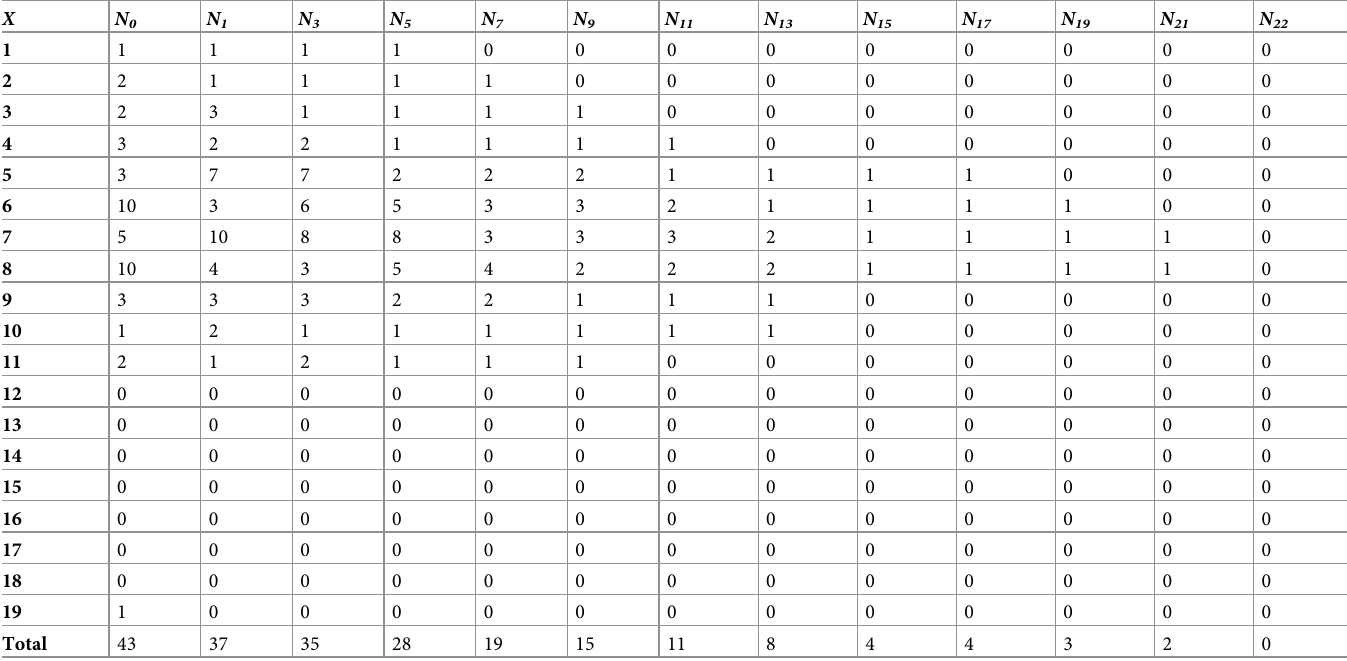
Table 11. Dynamic quantitative prediction model of P . flavus LM